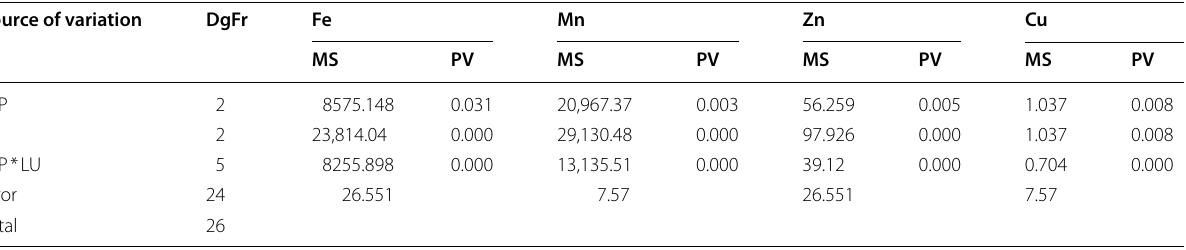
MS is mean square, PV is p-value, DgFr is the degree of freedom